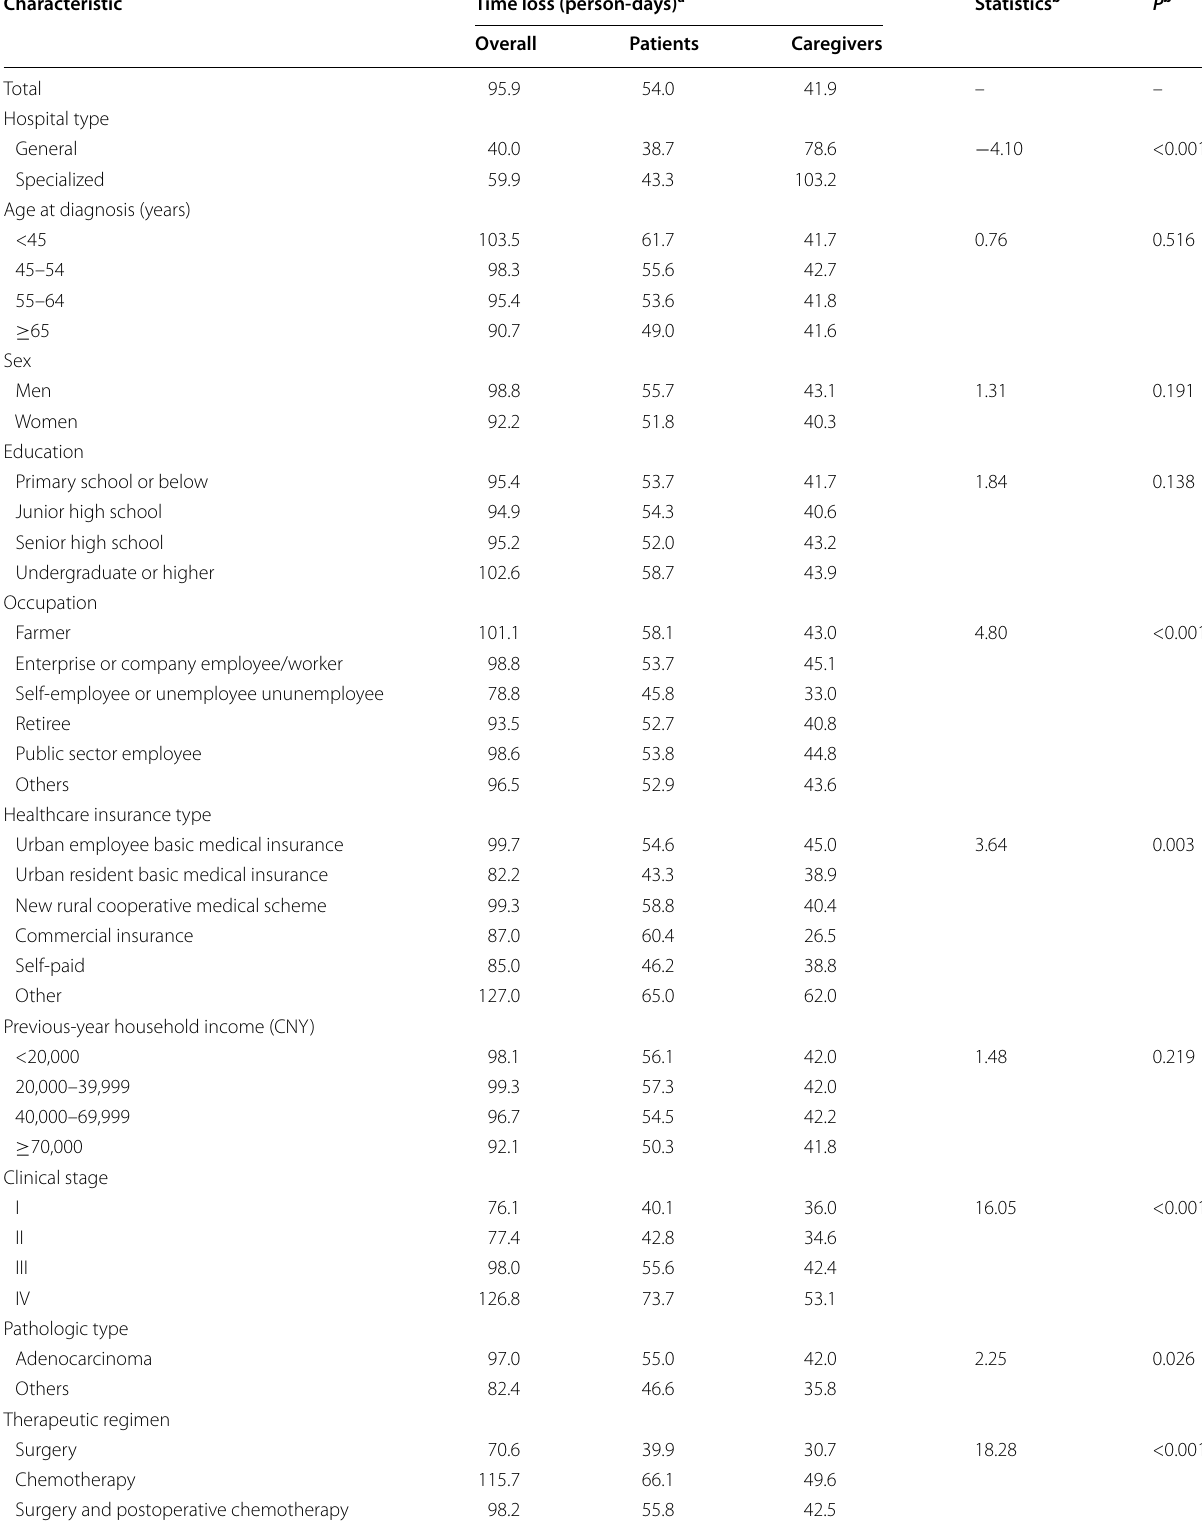
Table 6 Time loss due to colorectal cancer diagnosis and treatment